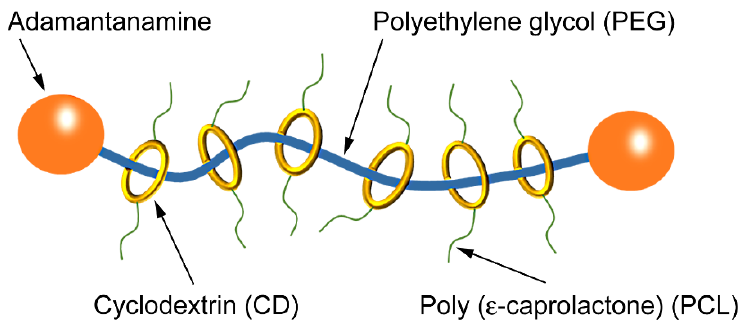
Figure 1. The chemical structure of polyrotaxane (PR).